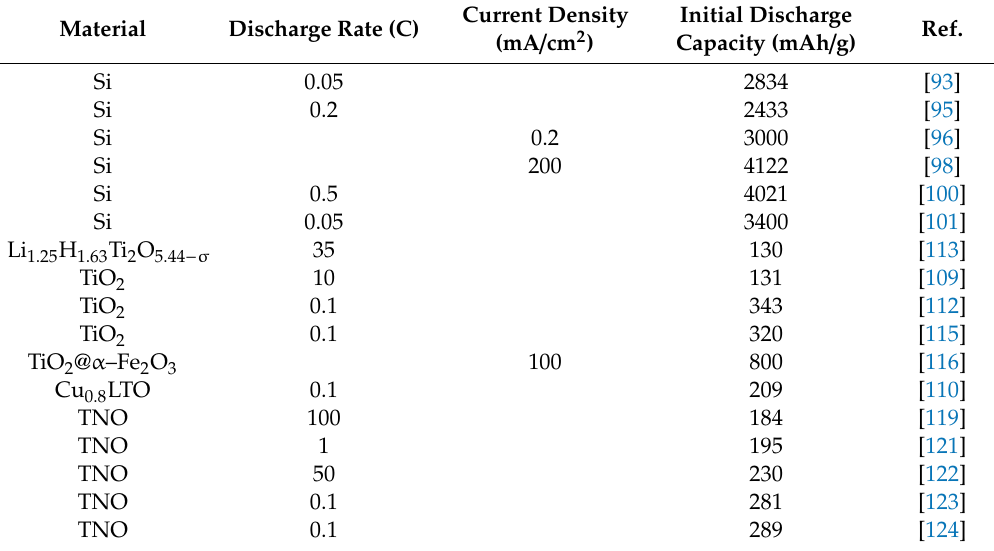
Table 1. Comparison of the discharge capacity among di ff erent anode